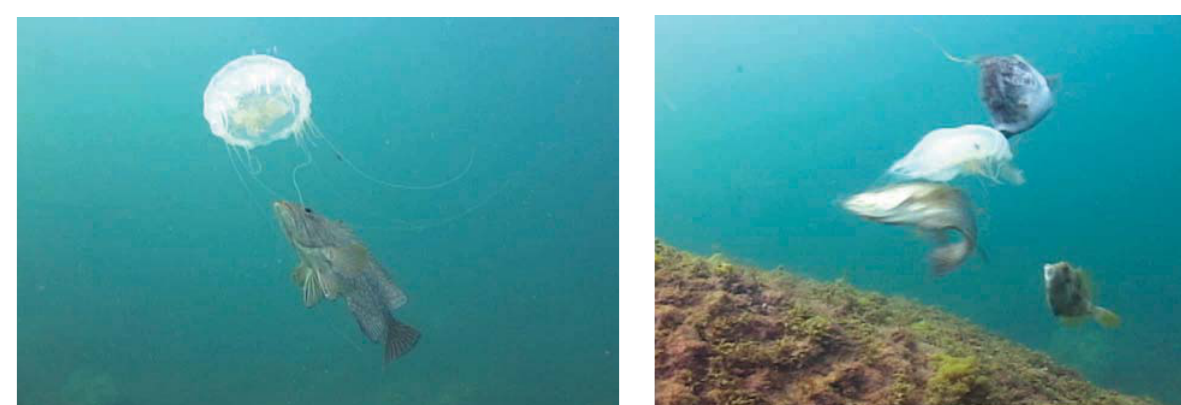
Fig. 1. A watchful comb grouper ( Mycteroperca acutirostris )